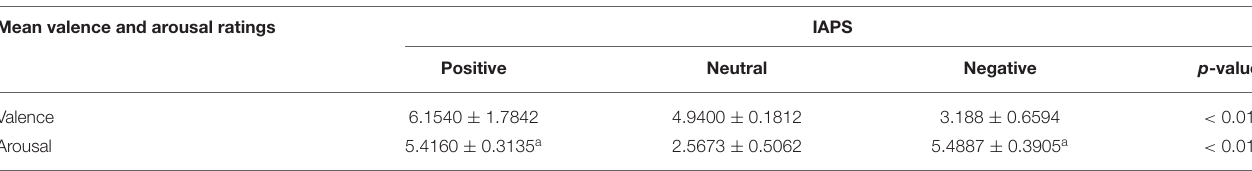
TABLE 2 | Means and standard deviations for arousal and valence for each IAPS. Mean valence and arousal